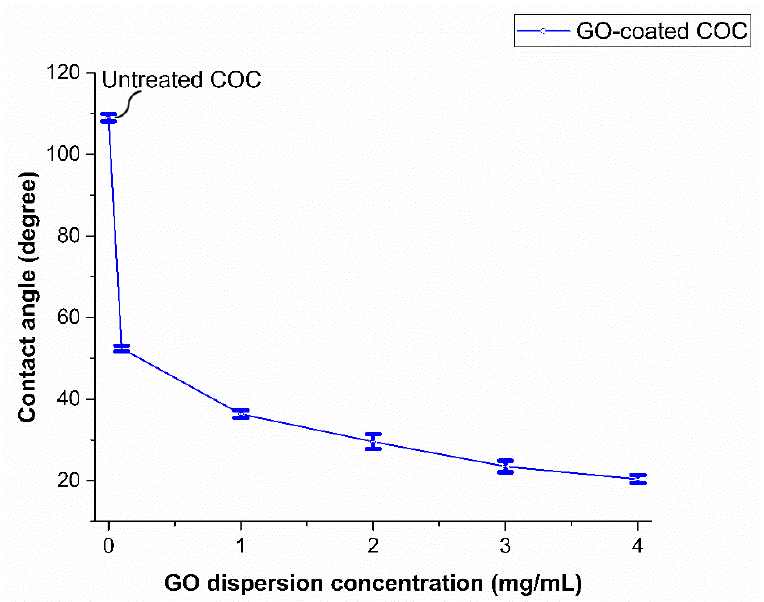
Figure 8. DI water contact angle on GO − coated COC surface as a function of GO dispersion concentration. Contact angle of untreated COC is 109 ◦ . All samples were treated for 5 min before the deposition of the GO film.